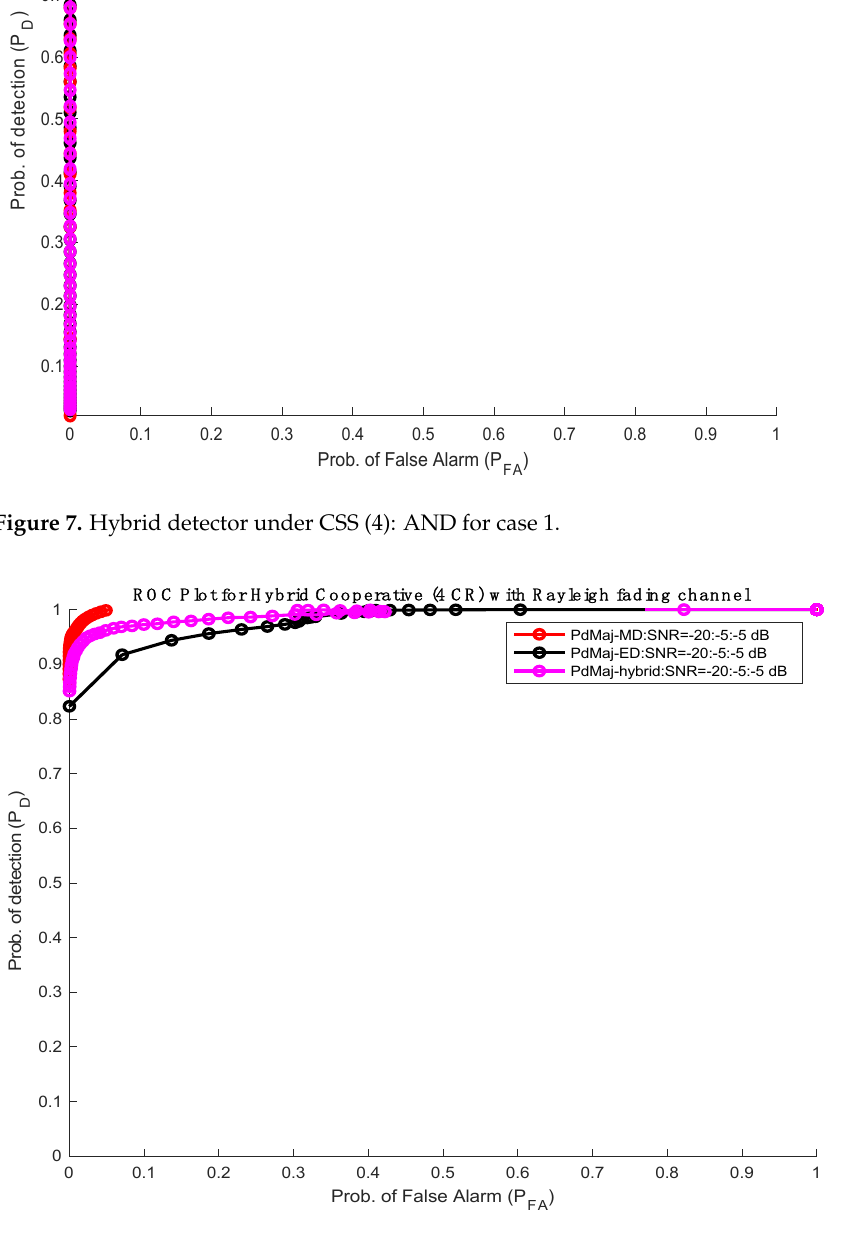
Figure 8. Hybrid detector under CSS (4): Majority for case 1. When HD selects ED for case 1, P D is 0.98 and P FA is 0 using OR rule, P D is 0.96 and P FA is 0 using AND rule, and P D is 0.94 and P FA is 0.1 using Majority rule. Cooperative spectrum sensing is simulated under heterogeneous networks from − 20 dB to − 5 dB SNR for both case 1 and case 2 of the HD model. Case 2: Random variable Z = below 0.7 (PU information available), select hybrid =